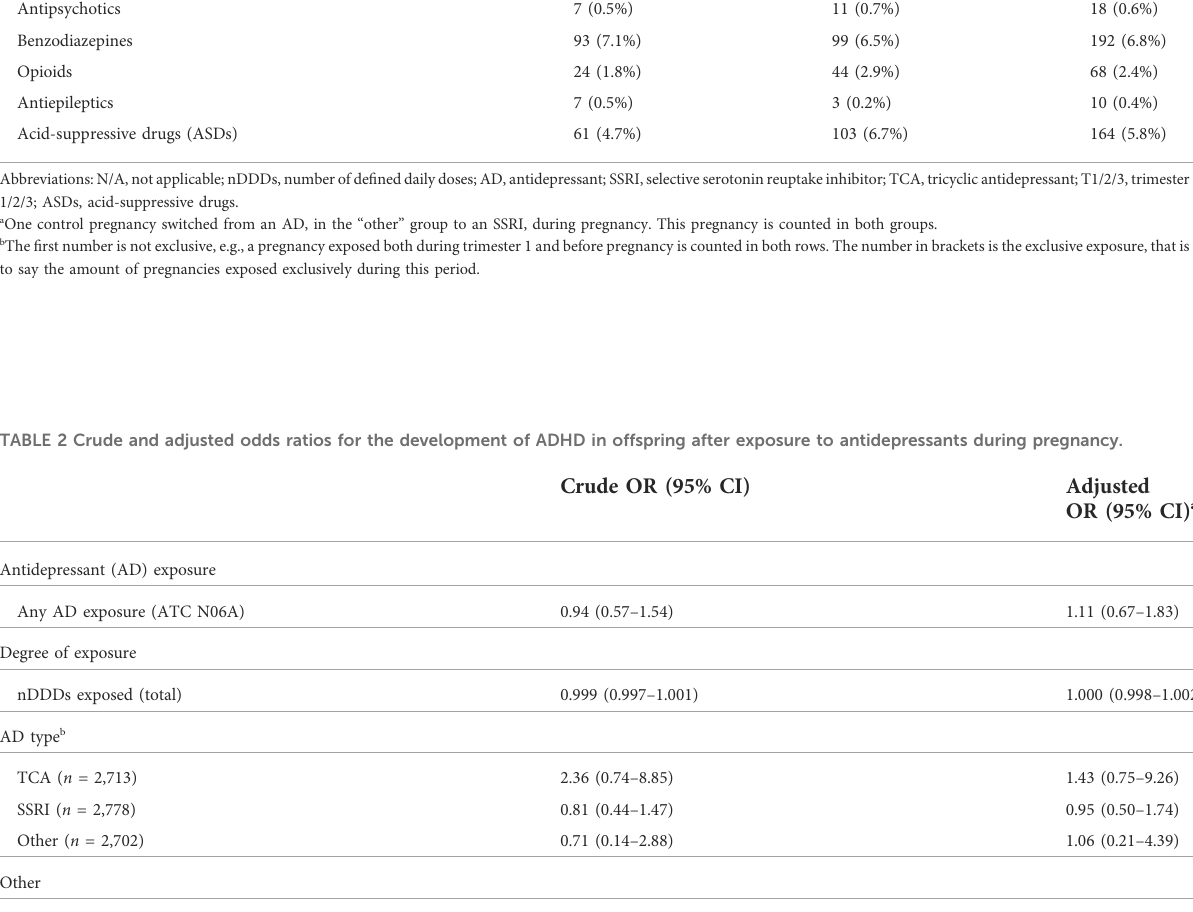
exposure during pregnancy and ADHD in the offspring, a crude OR of 0.94 (95% CI 0.57 – 1.54) was determined (Table 2). The multivariate logistic regression model yielded an adjusted OR of 1.11 (95% CI 0.67 – 1.83). When taking the degree of exposure (a continuous variable) as the